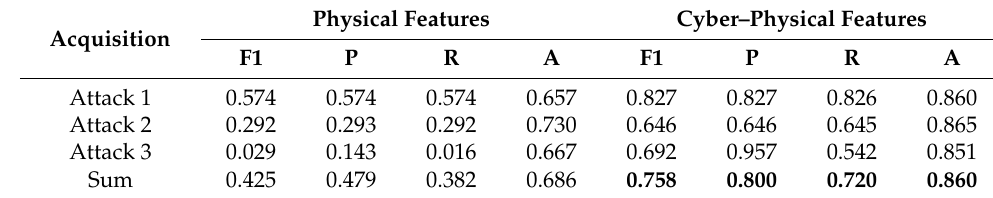
Table 7. Performance of the proposed model.